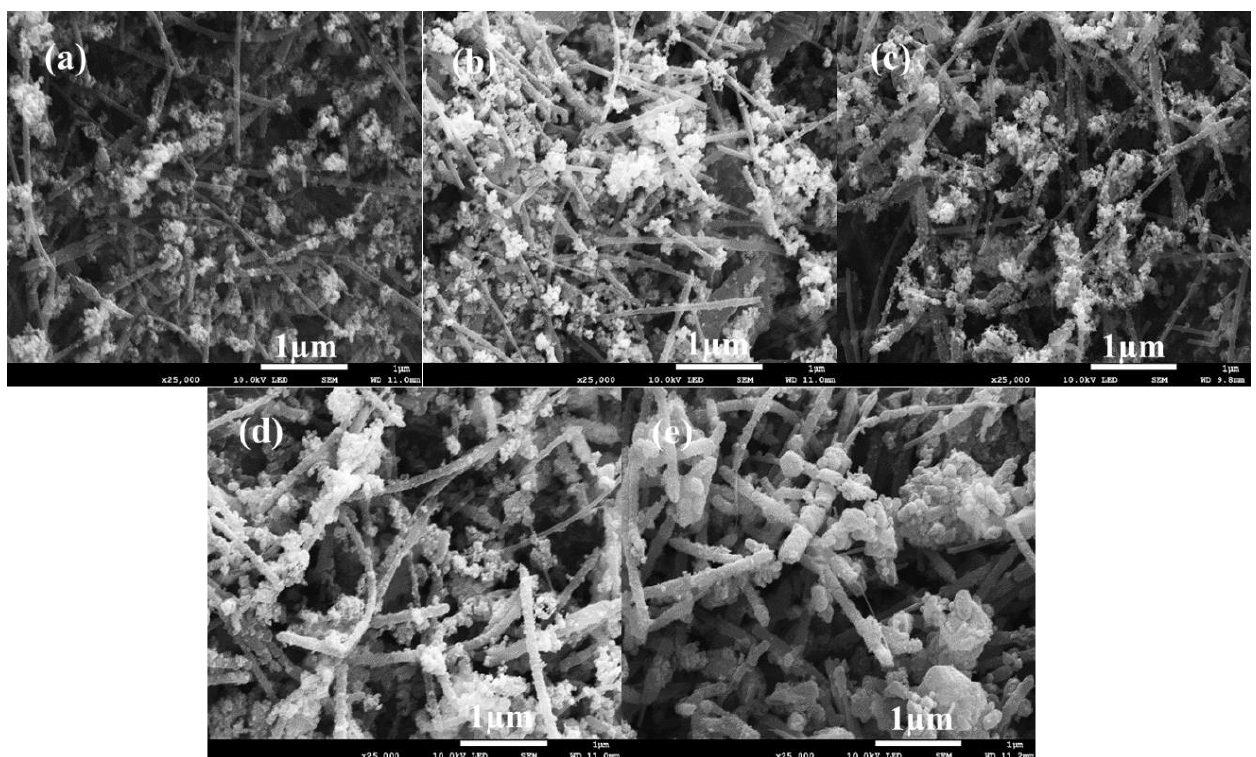
Figure 1. SEM images of C 35 /R y M electrodes with ( a ) 11, ( b ) 16, ( c ) 17, ( d ) 20 and ( e ) 23 wt% of Ru.